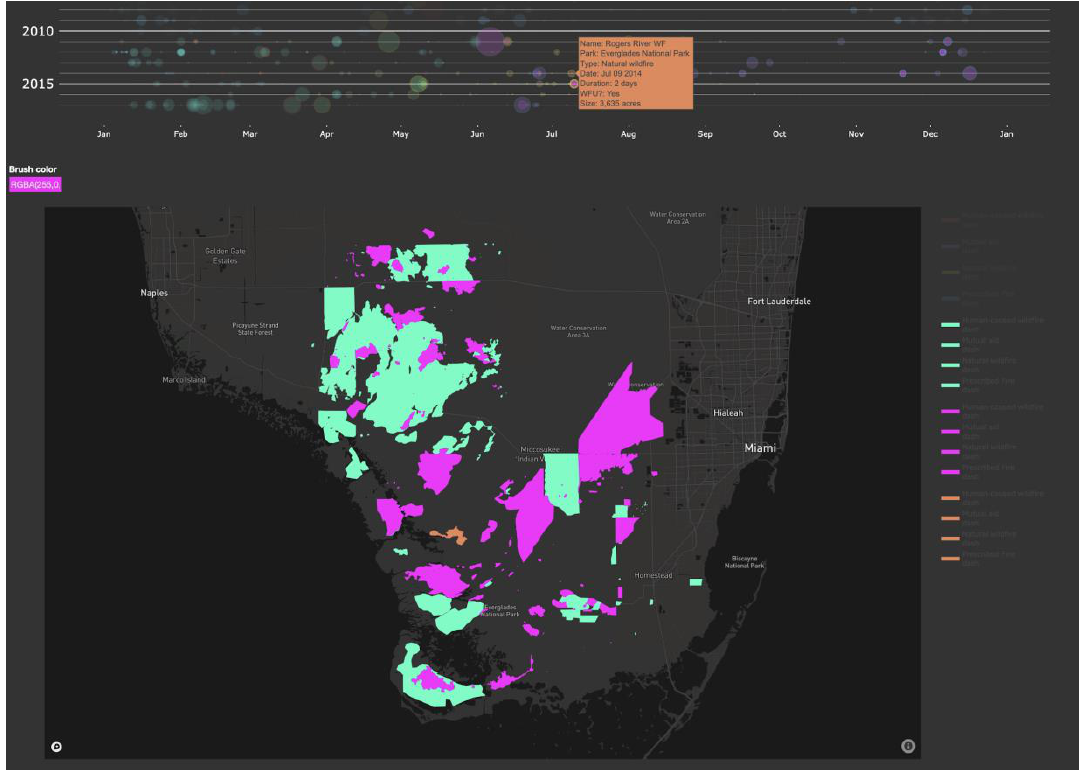
Figure 8. Fire perimeters in Everglades National Park and Big Cypress National Preserve, highlighted using the brush tool on the fire history chart (top). Here, fires occurring between January and June (2010–2017) are highlighted using the turquoise brush color, while fires occurring between June and December (2010–2017) are highlighted in purple. Selecting a single fire on the map (e.g., in orange) will highlight that fire’s point and hover text in the fire history chart.